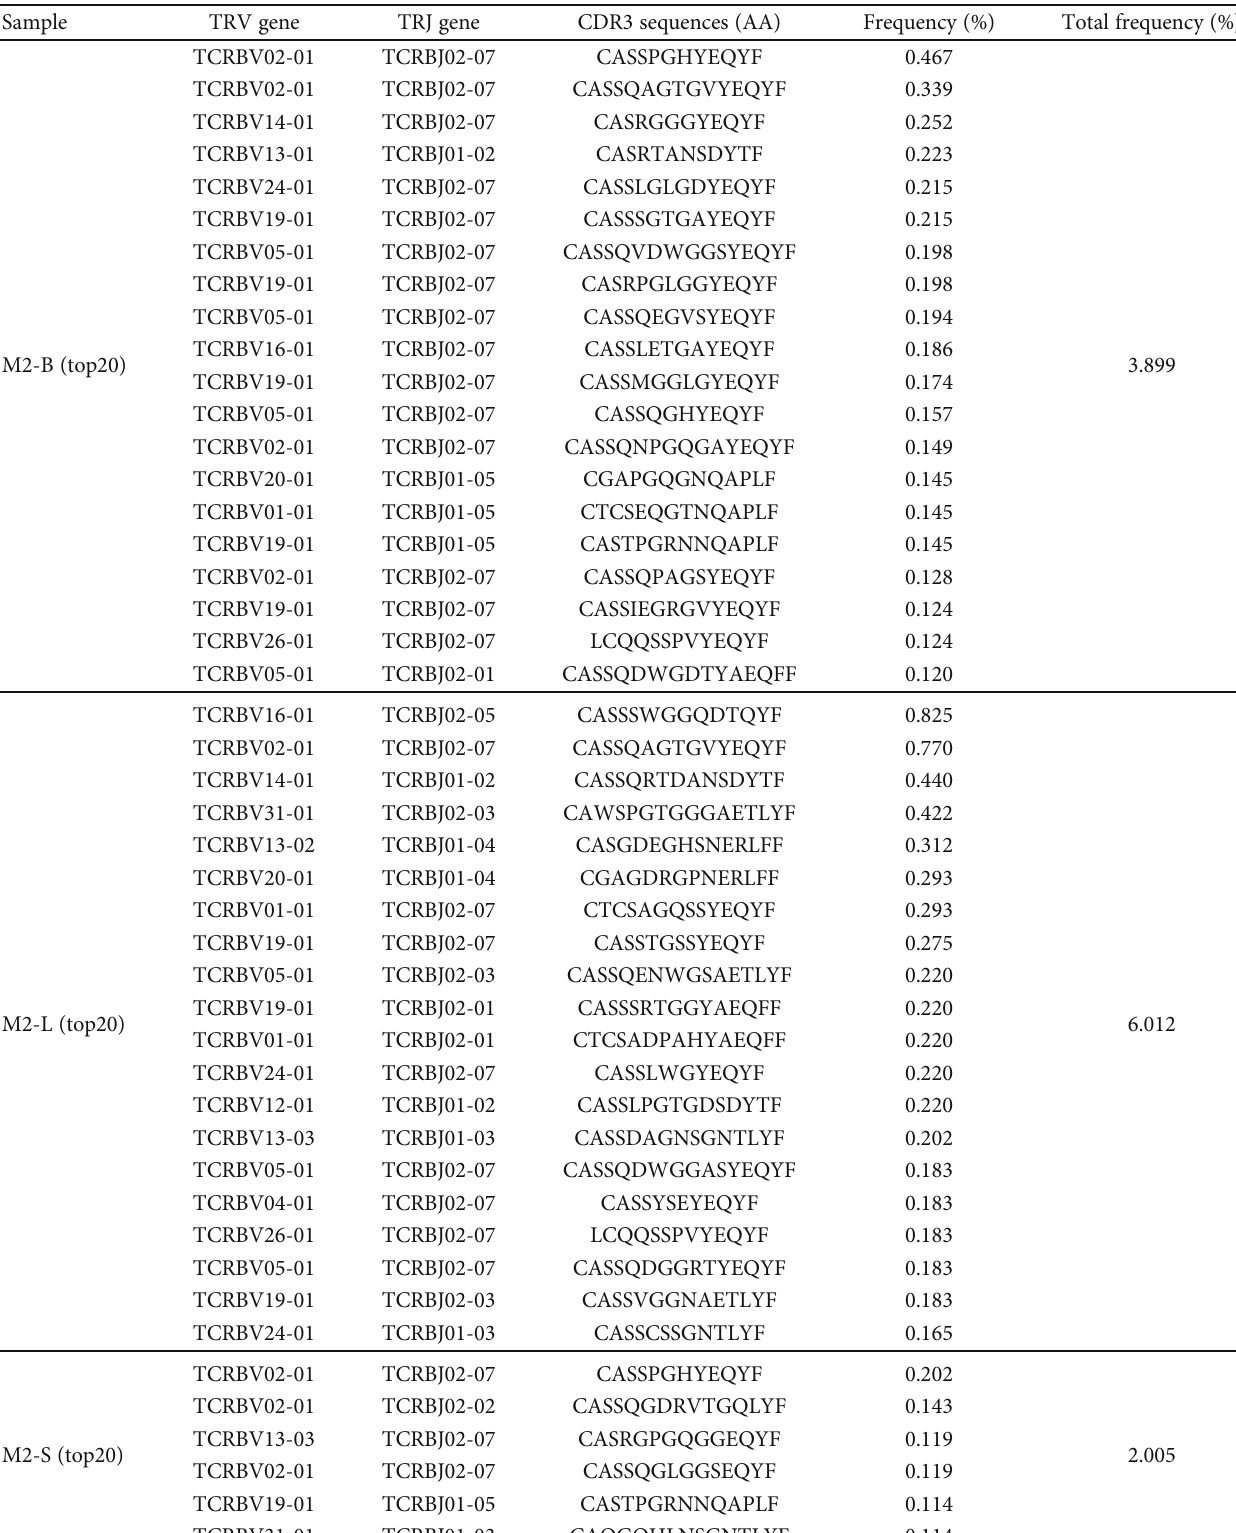
Table 9: Analysis of composition and characteristics of frequency for the top twenty sequences and the usage of TRBV and TRBJ gene, CDR3 AA of CD4 + CD25 + T cells TCR β CDR3 repertoires in breast tumor tissues, lung metastatic tissues, and spleens from 4T1 tumor-bearing BALB/c mouse